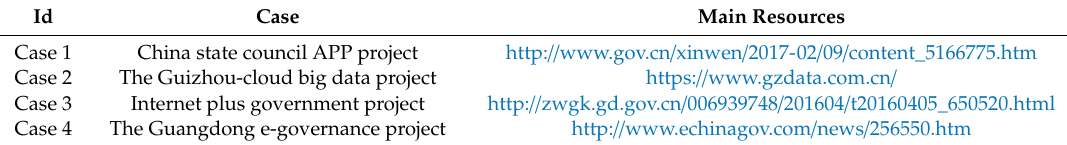
Table 2. Analyzed case